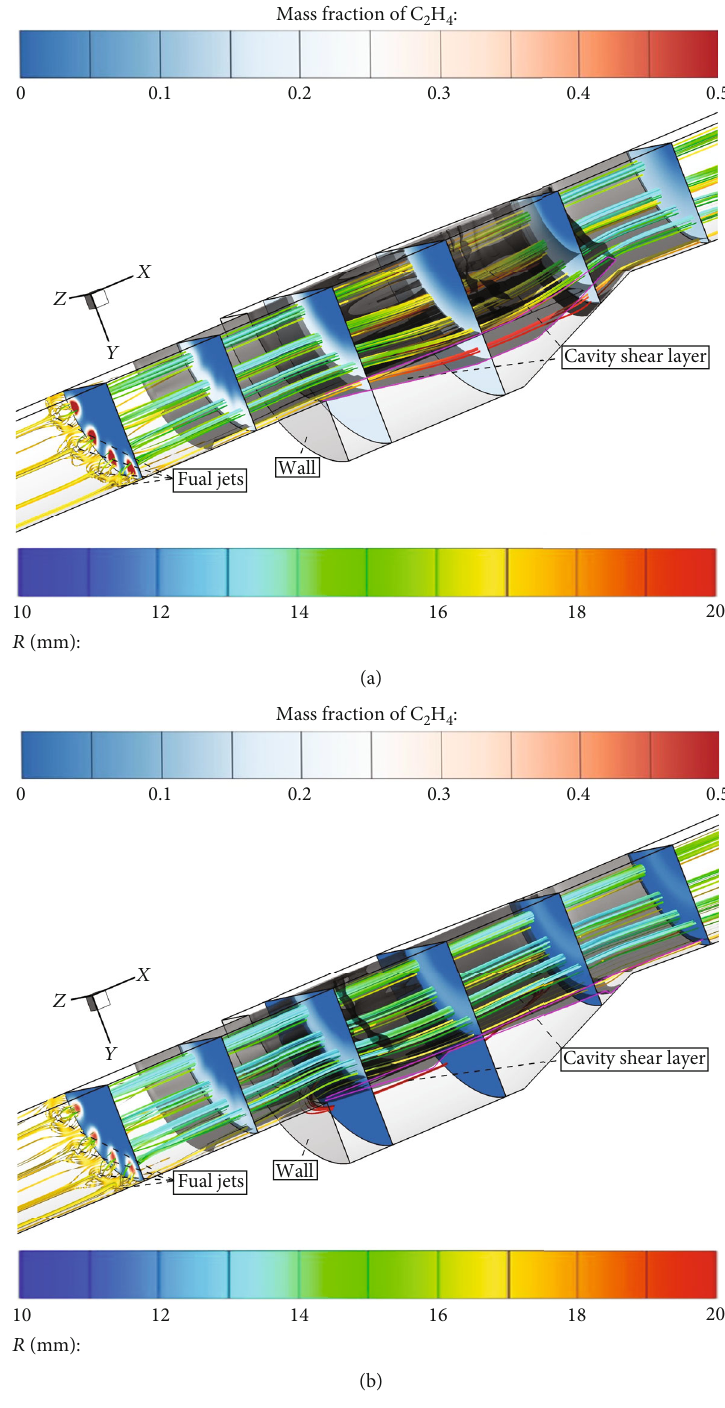
Figure 4: Fuel distribution of the (a) nonreacting and (b) reacting fl ow fi elds of case-22.5; the streamline is colored by the local distance to the axis of symmetry, and the isosurface is de fi ned as the surface where the partial derivative in the radial direction of streamwise velocity ∂ U / ∂ R equals -15000 s -1 to display the boundary of the cavity shear